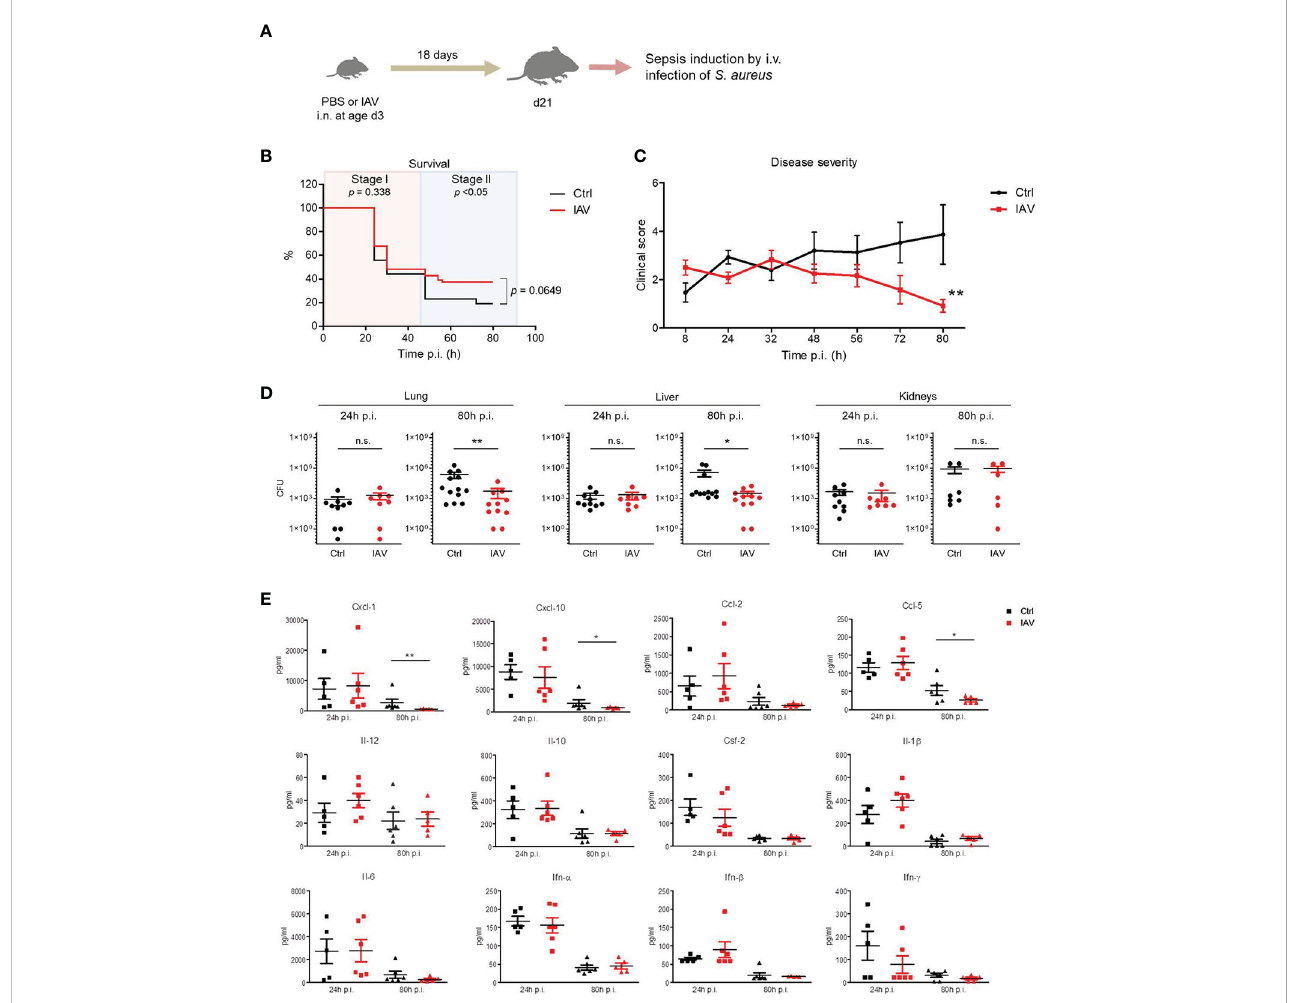
FIGURE 1 Control of S. aureus infections in juvenile mice is improved after silent neonatal exposure to IAV. Newborn mice were treated intranasally (i.n.) at d3 of life with PBS (control, Ctrl) or 5 PFU of the H1N1 virus (IAV). After 18 days, sepsis was induced in these mice by intravenous (i.v.) application of S. aureus . (A) Experimental setup. (B) Survival was observed for 80 h post-infection (p.i.) with S. aureus and plotted as percentages over time (Mantel-Cox test). (C) Clinical scores at indicated time points p.i., plotted as means ± SEM. **p < 0.01 ( post hoc 2-way ANOVA Bonferroni test) (Ctrl n = 52 from 7 litters, IAV n = 56 from 7 litters). (D) Bacterial burden was determined in independent experiments in indicated organs at 24 h and 80 h p.i. (each group n = 6-13 from 2-7 litters, respectively). Plotted are means ± SEM, *p < 0.05, **p < 0.005 (MWU test). (E) Plasma cytokine levels at 24 h and 80 h p.i. (each group n = 5-6, each from 2 independent experiments). Plotted are means ± SEM, *p < 0.05, **p < 0.005 ( post hoc Kruskal-Wallis Dunn ’ s multiple comparison test). n.s., not signi fi